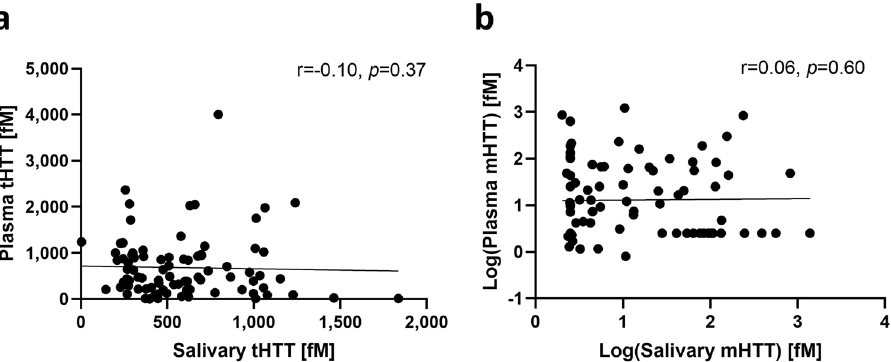
Figure 1. Associations between plasma and salivary tHTT ( a ) and mHTT ( b ) in HTT mutation-carriers. Data in ( b ) was log-transformed for graphical presentation after statistical testing. Statistical comparisons conducted using Spearman’s rho.